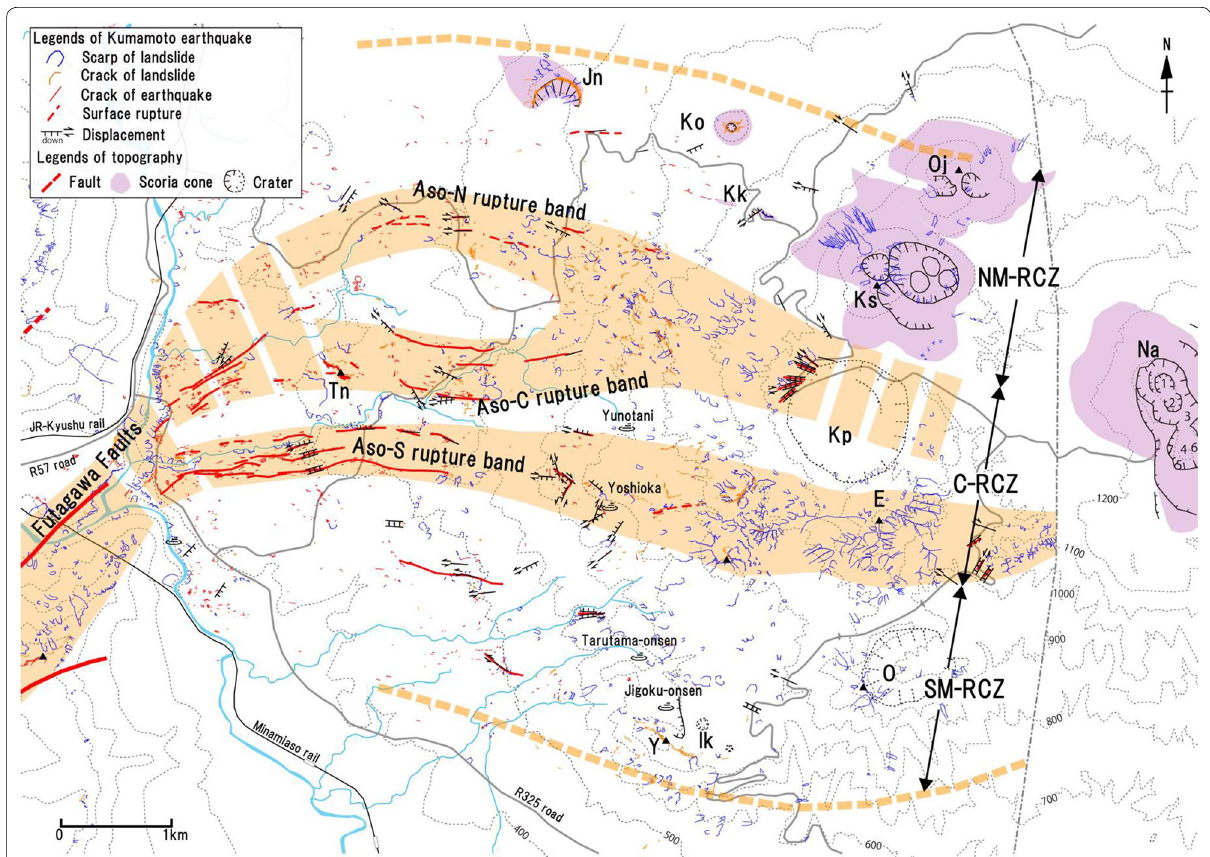
Fig. 10 Distribution map of ruptures concentration zone (RCZ) with landslides concentrated on Aso volcanic edifice. Orange bands denote the rupture band, and the dashed orange line denotes the RCZ. C-RCZ: core of RCZ; NM-RCZ: northern margin of RCZ; SM-RCZ: southern margin of RCZ. Nakadake crater numbers 1–7 are shown in Ono and Watanabe